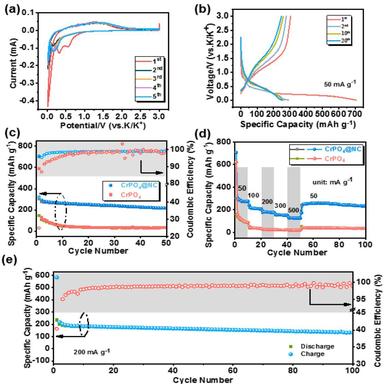
(a) CV curves of first five cycles and (b) discharge/charge curves of CrPO4@NC at 50 mA g− 1 , (c) cycle capacity at 50 mA g− 1 and (d) rate capability of the CrPO4@NC and CrPO4 samples, (e) long-life cycling performance of CrPO4@NC electrode.